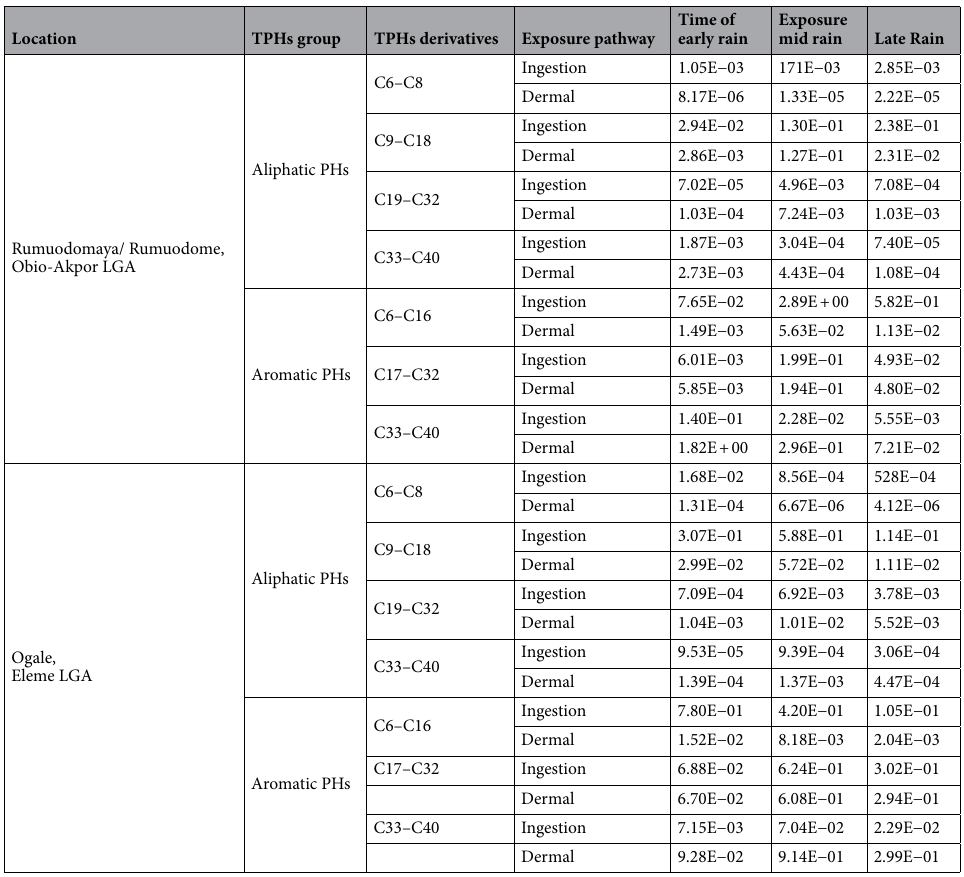
Table 11. Hazard Quotient for adult non-risk